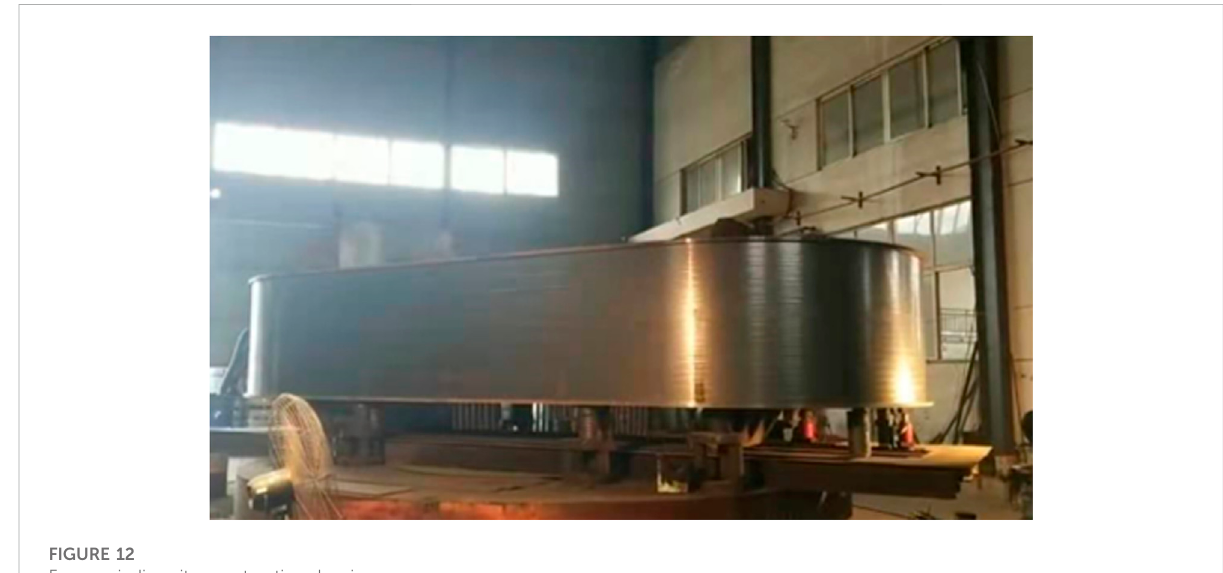
FIGURE 12 Frame winding site construction drawing.